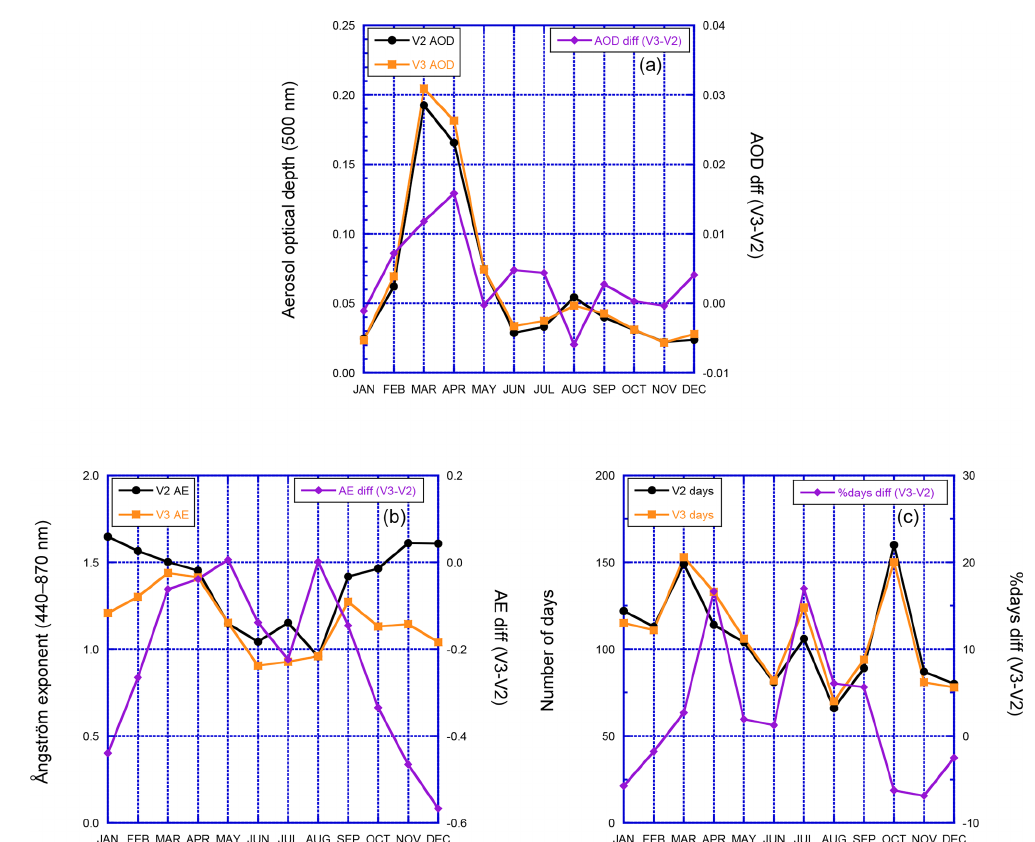
Figure 24. Similar to Fig. 23 except for Lulin, Taiwan (lat 23.47, long 120.87), from 2006 to